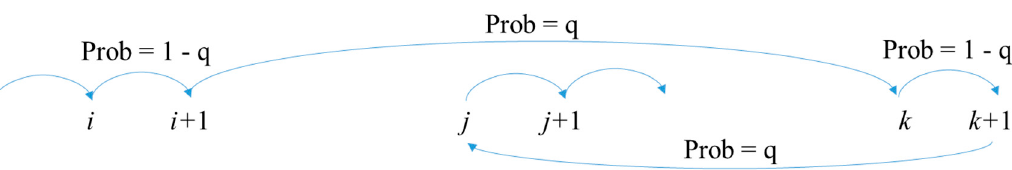
Figure 2. Stationary bootstrap process where the arrows indicate sampling of returns from the original series.